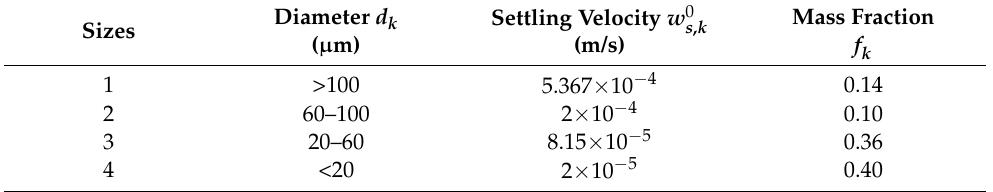
Table 2. Particle sizes, settling velocities, and mass fraction of the sediment adopt in the simulation.